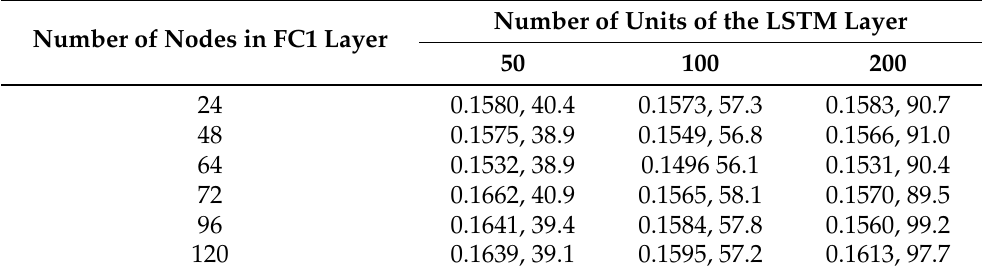
Table 3. Validation losses and training time (s) of the seq2seq module with different hyperparameters.